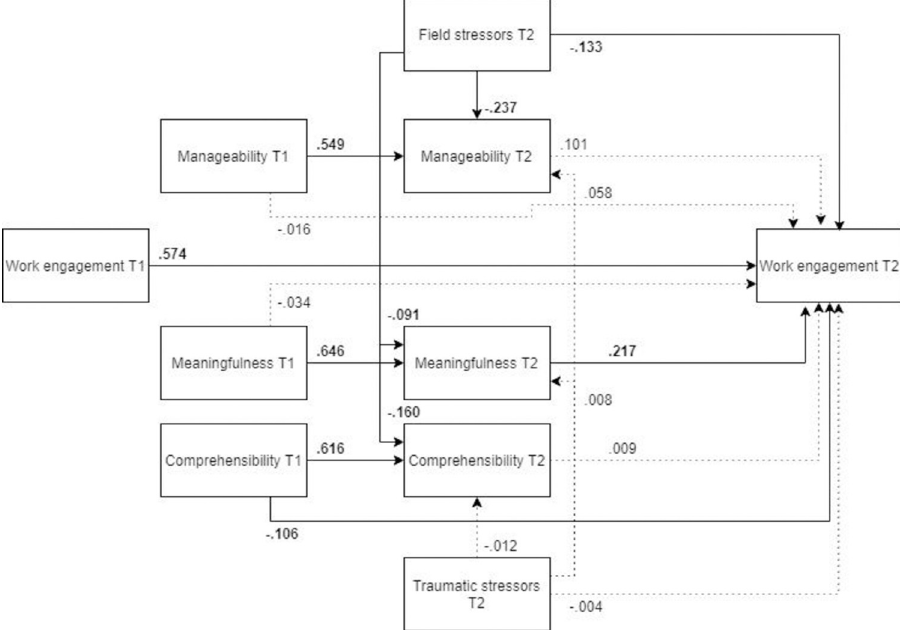
Fig 18. Tested structural equation model of work engagement.